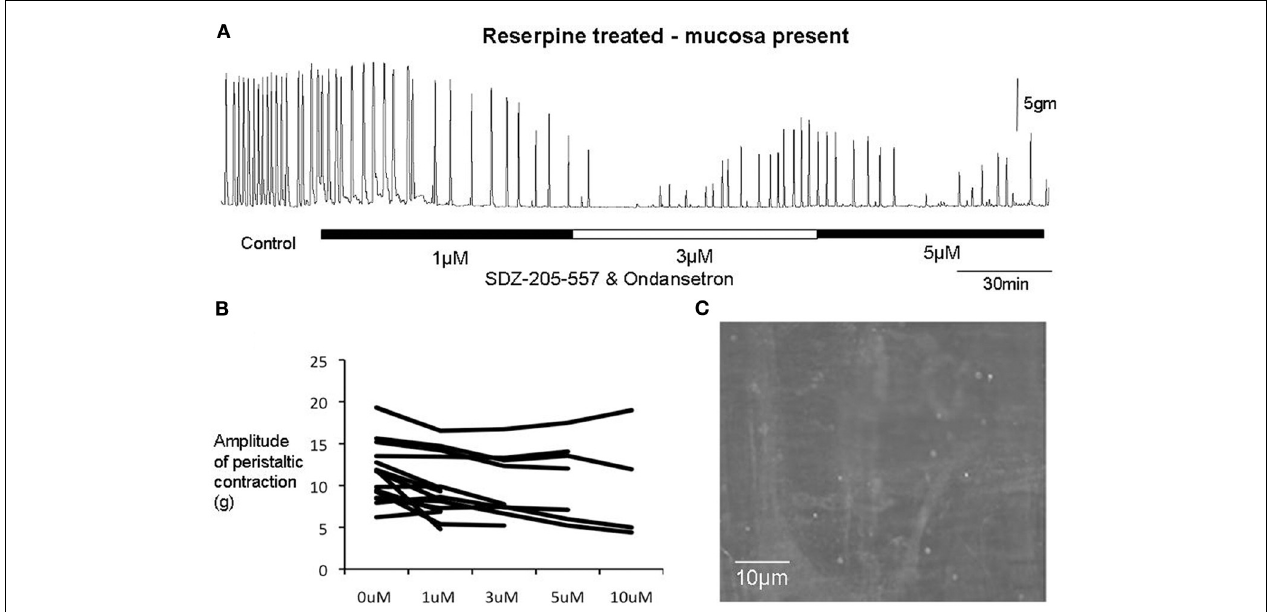
FIGURE 6 | (A) In a reserpine-treated animal with mucosa present, combined application of SDZ-205-557 and ondansetron caused temporary inhibition of peristalsitic contractionswhich recoveredeven with increasing concentrations up to 5 µ M. (B) Shows changes in amplitude of peristaltic contractions from